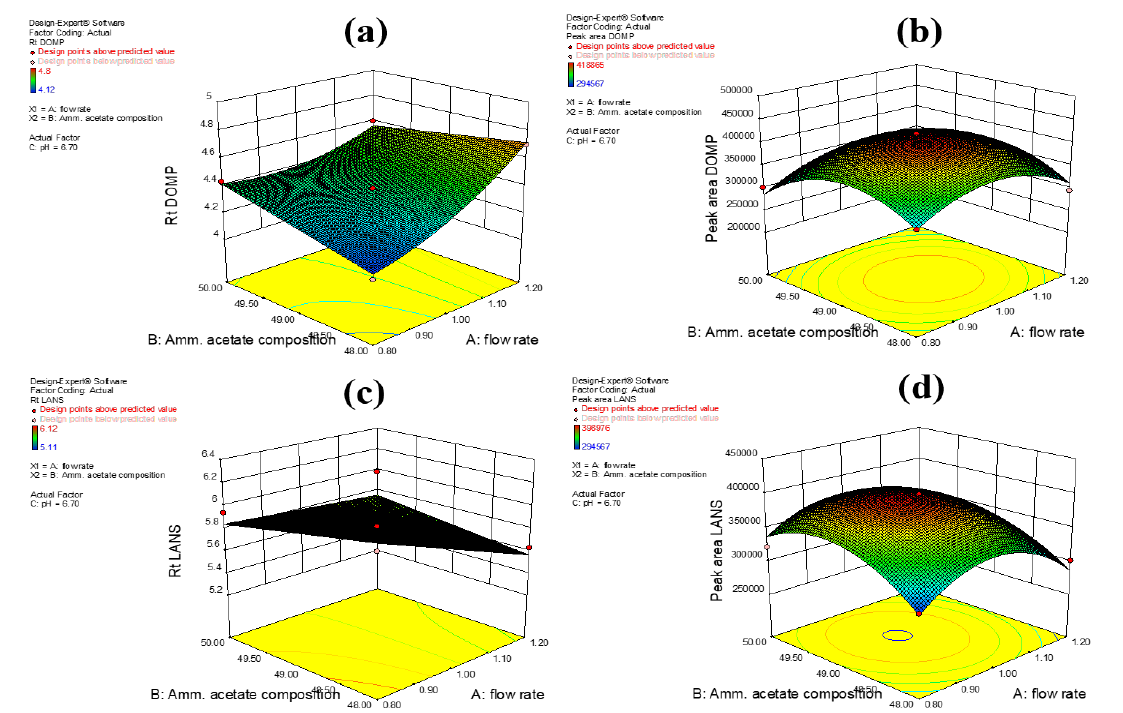
Figure 3. 3D surface responses showing ( a ) retention time of DOMP (Y 1 ), ( b ) peak area of DOMP (Y 2 ), ( c ) retention time of LANS (Y 3 ), and ( d ) peak area of LANS (Y 4 ).